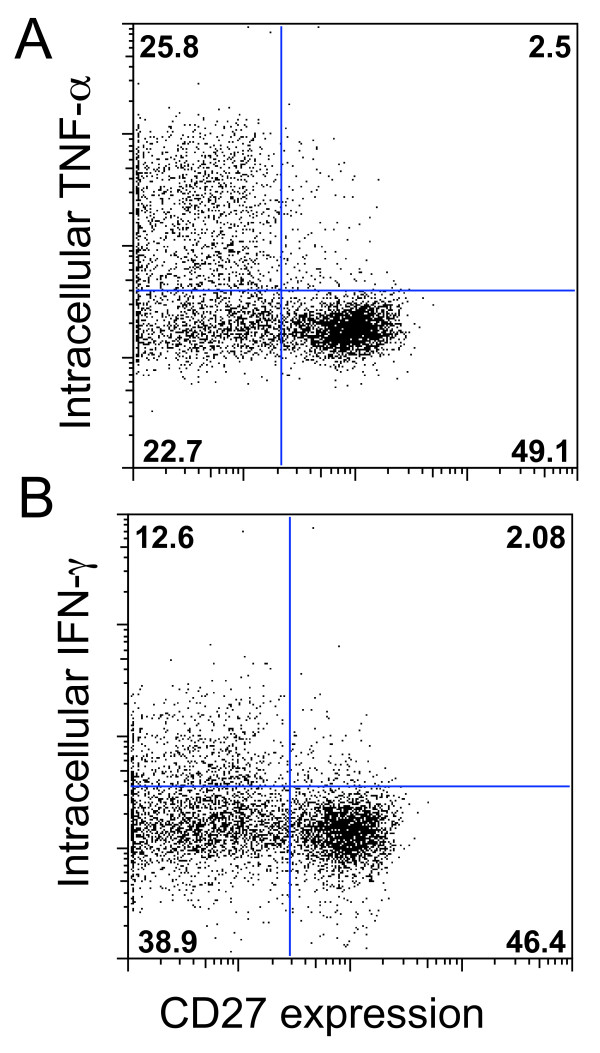
Intracytoplasmic cytokine production by day 14 anti-CD3 stimulated CD8 T cells stimulated for 4 hours with PMA/A23187. By comparison to CD27- cells, the CD27+ subset produced little intracytoplasmic (A) tumor necrosis factor (TNF-α) or (B) interferon- γ (IFN-γ). Similar results were obtained in each of 4 studies.